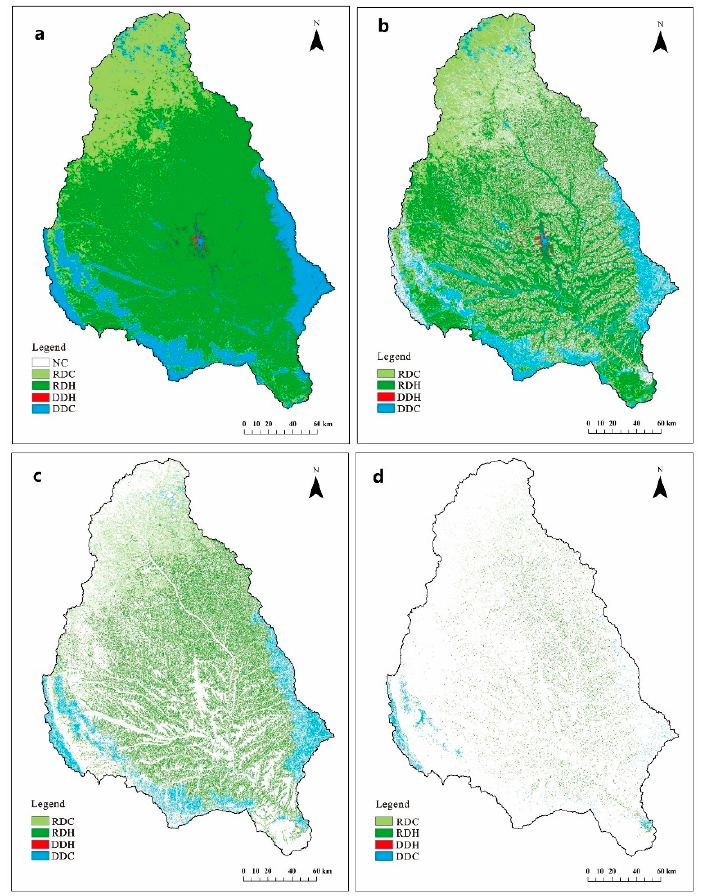
Figure 5. Spatial pattern of different conditions of the NPP change of the entire basin ( a ); areas with a slope less than 15° ( b ); areas with a slope between 15 and 25 ° ( c ); and areas with a slope greater than 25 ° ( d ) in the Jinghe River basin from 2000 to 2014. NC is the vegetation with no change, RDC is the restoration of vegetation dominated by meteorological conditions, RDH is the restoration of vegetation dominated by human activities, DDC is the degradation of vegetation dominated by meteorological conditions, DDH is the degradation of vegetation dominated by human activities.